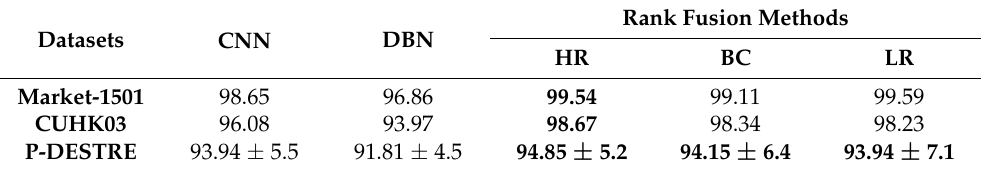
Table 9. Rank-1 identification rate of the developed ReID-DeePNet system on three different ReID datasets using rank-level fusion.